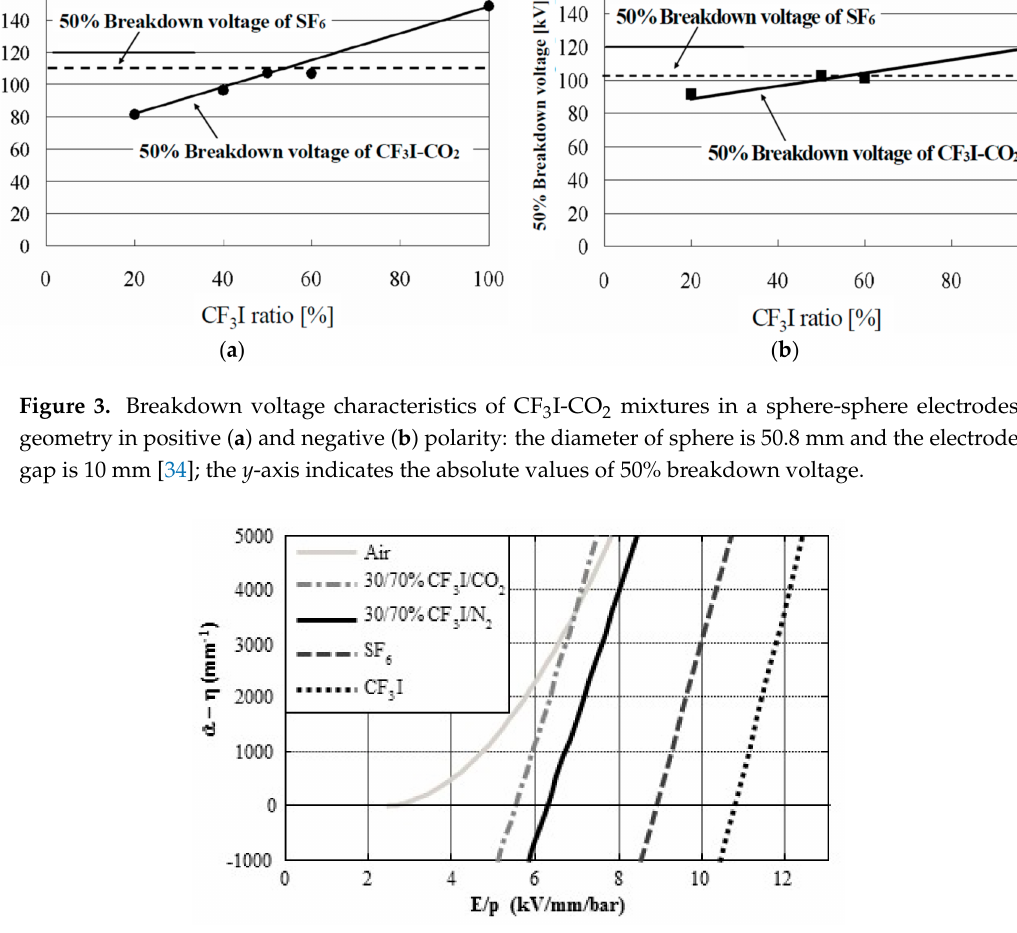
Figure 4. Effective ionization coefficients in various gases (Air, SF 6 and CF 3 I,) and gas mixtures (30/70% CF 3 I/N 2 and 30/70% CF 3 I/CO 2 ) [35].